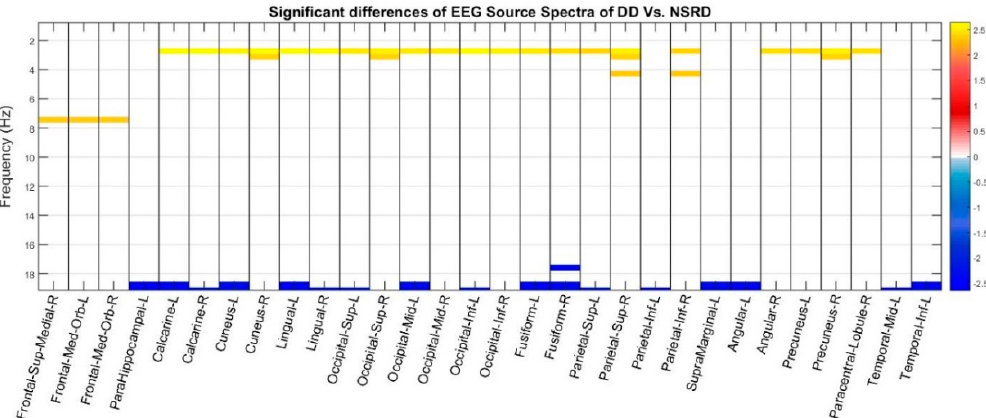
Figure 2. Significant differences of the t test at the sources spectra of DD vs NSRD. Red and yellow values indicate an excess of DD compared to NSRD; values in the blue scale indicates excess of NSRD compared to DD. Threshold corrected by multiple comparisons. Differences are concentrated in very narrow bands of frequencies. In general, DD have an excess of slow activity (Delta and slightly Theta) and a defect of fast activity (Beta band).